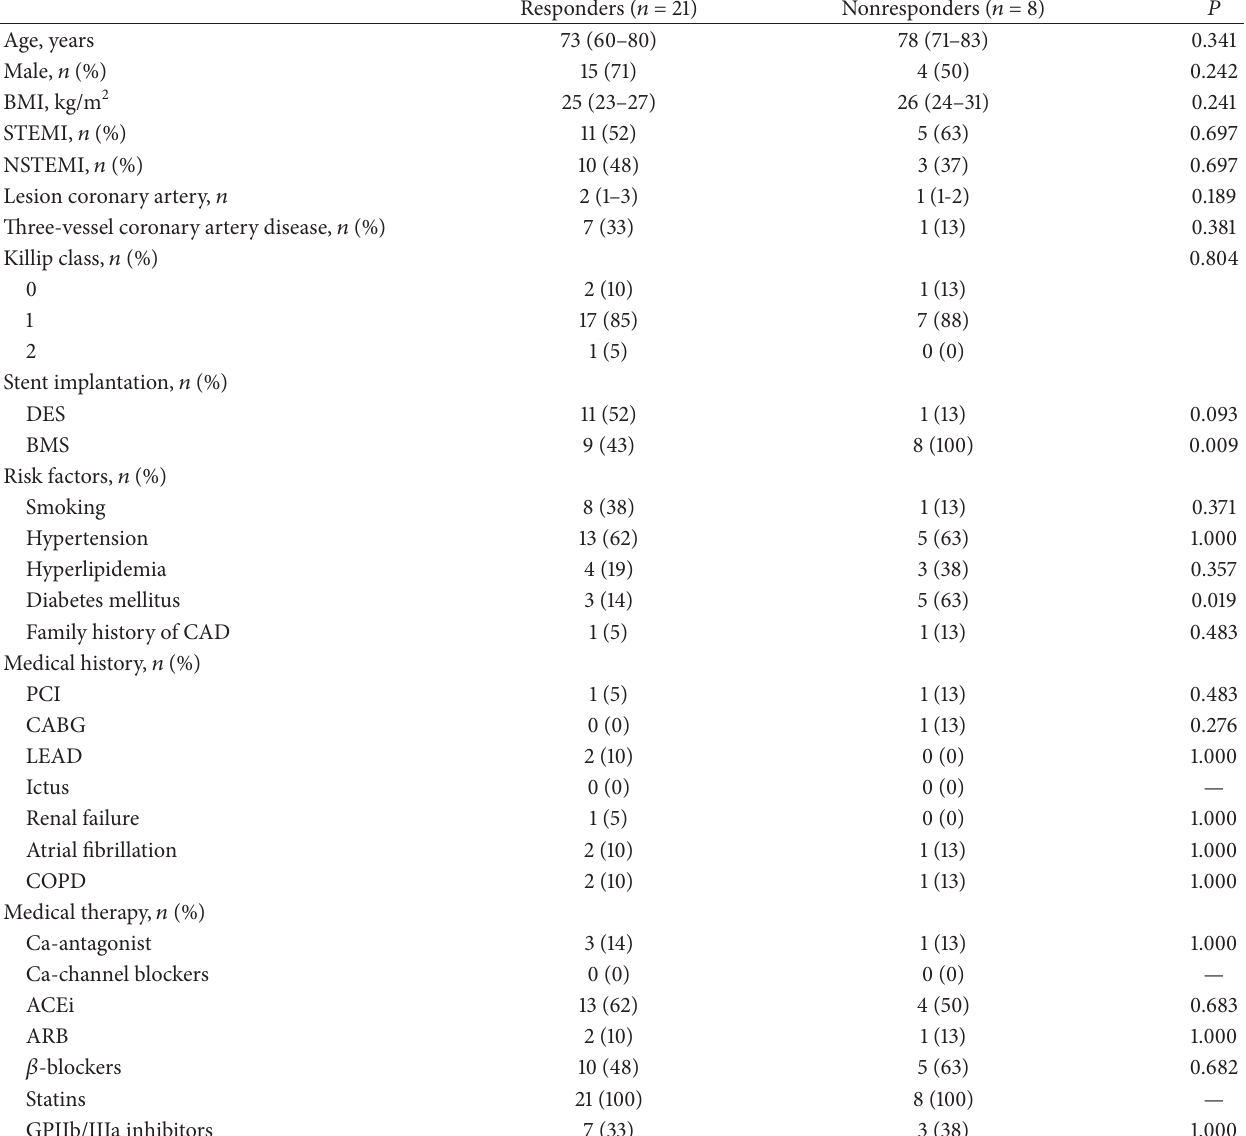
Table 1: Clinical characteristics between clopidogrel-responder and -nonresponder